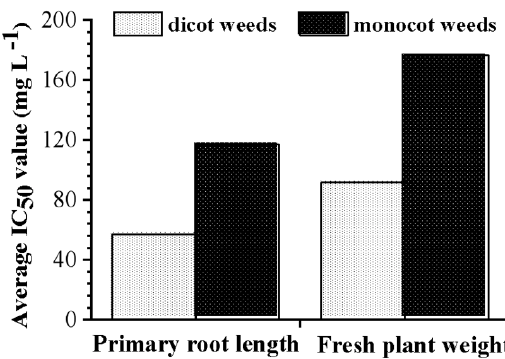
Table 1. Inhibition rate (%) and IC 50 values of dirhamnolipid on the primary root length and fresh plant weight of the nine test plants (7d) a .